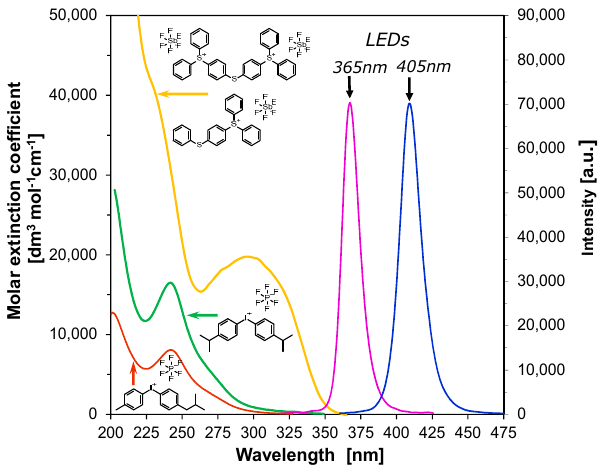
Figure 4. Comparison of absorption spectra of common cationic photoinitiators with emission spectra of 365 nm UV-A LED and visible LED at 405